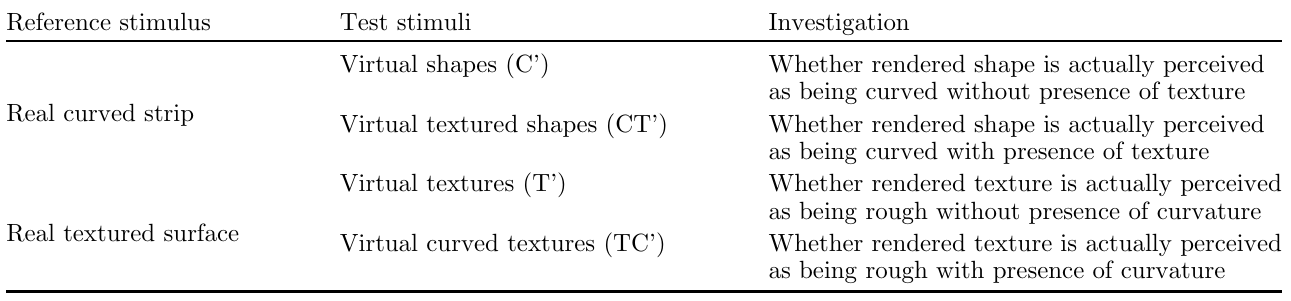
Table 3. Investigation purposes for each pair of reference and test stimuli in Exp. 2.